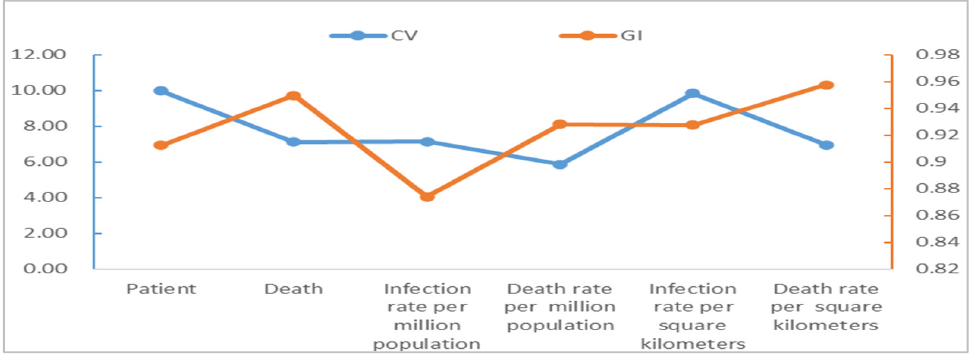
Figure 3. Spatial heterogeneity analysis of COVID-19 in China cities. Note: CV stands for coefficient of variation and GI stands for Gini index.